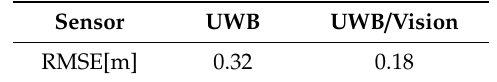
Table 3. Root mean square error (RMSE) values of the positioning accuracy of UWB alone and UWB /